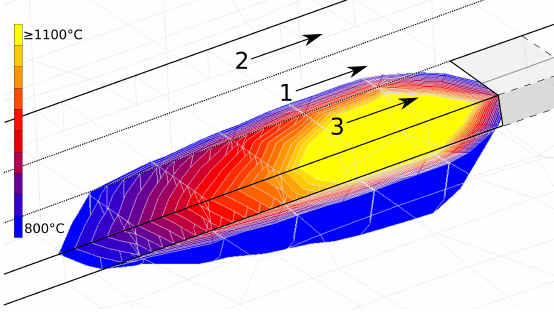
Figure 6. Temperature contours in weld